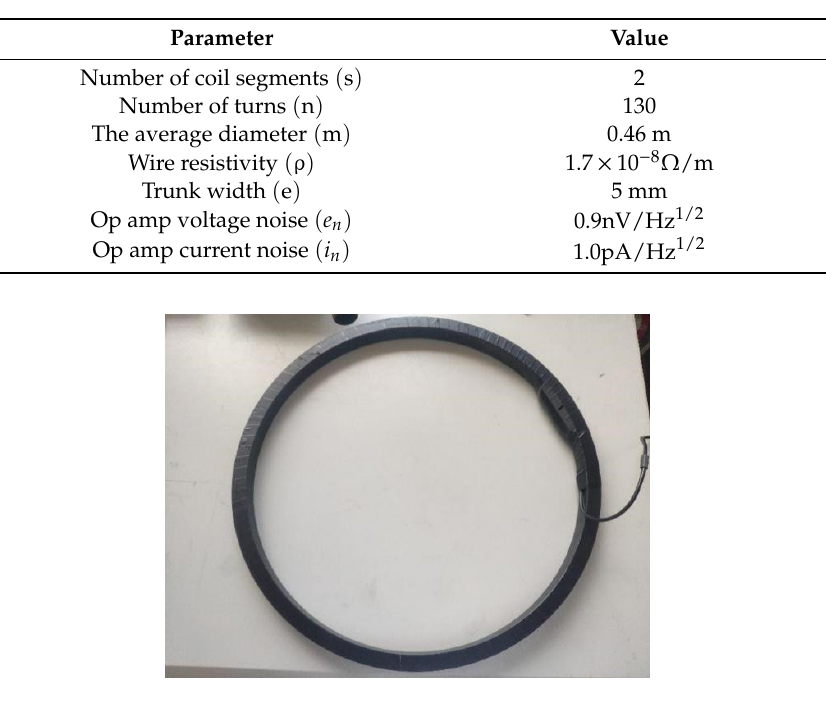
Table 1. Coil sensor parameters.